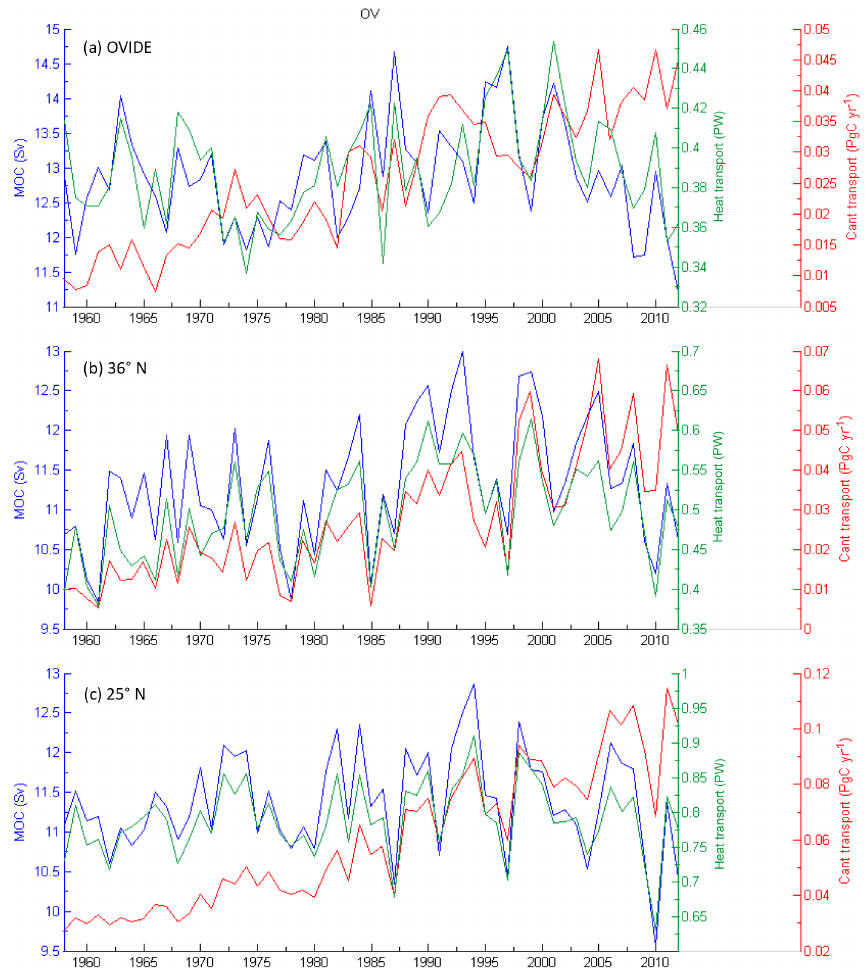
Figure 10. Annual time series of MOC intensity (Sv), heat transport (PW) and Cant transport (PgCyr − 1 ) simulated by the model at (a) the OVIDE section, (b) 36 ◦ N and (c) 25 ◦